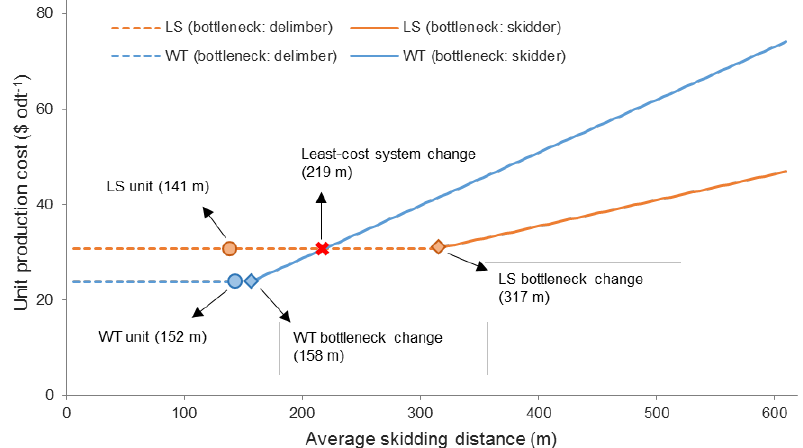
Figure 6. Changes in unit production costs over a range of skidding distance estimated for the lop and scatter (LS) and whole-tree harvesting (WT)